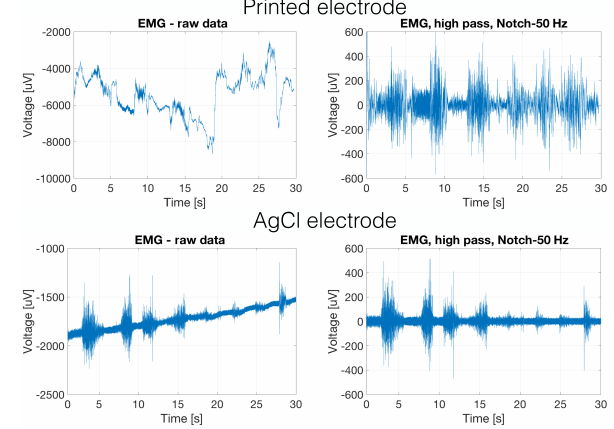
Figure 19. Comparison of sEMG signals acquired with printed and regular AgCl